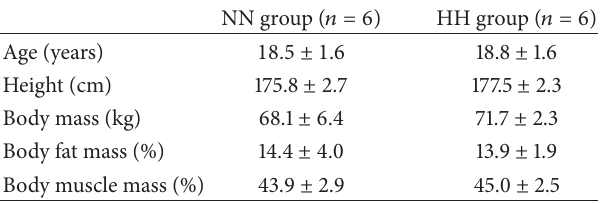
Table 1: Baseline characteristics of the study